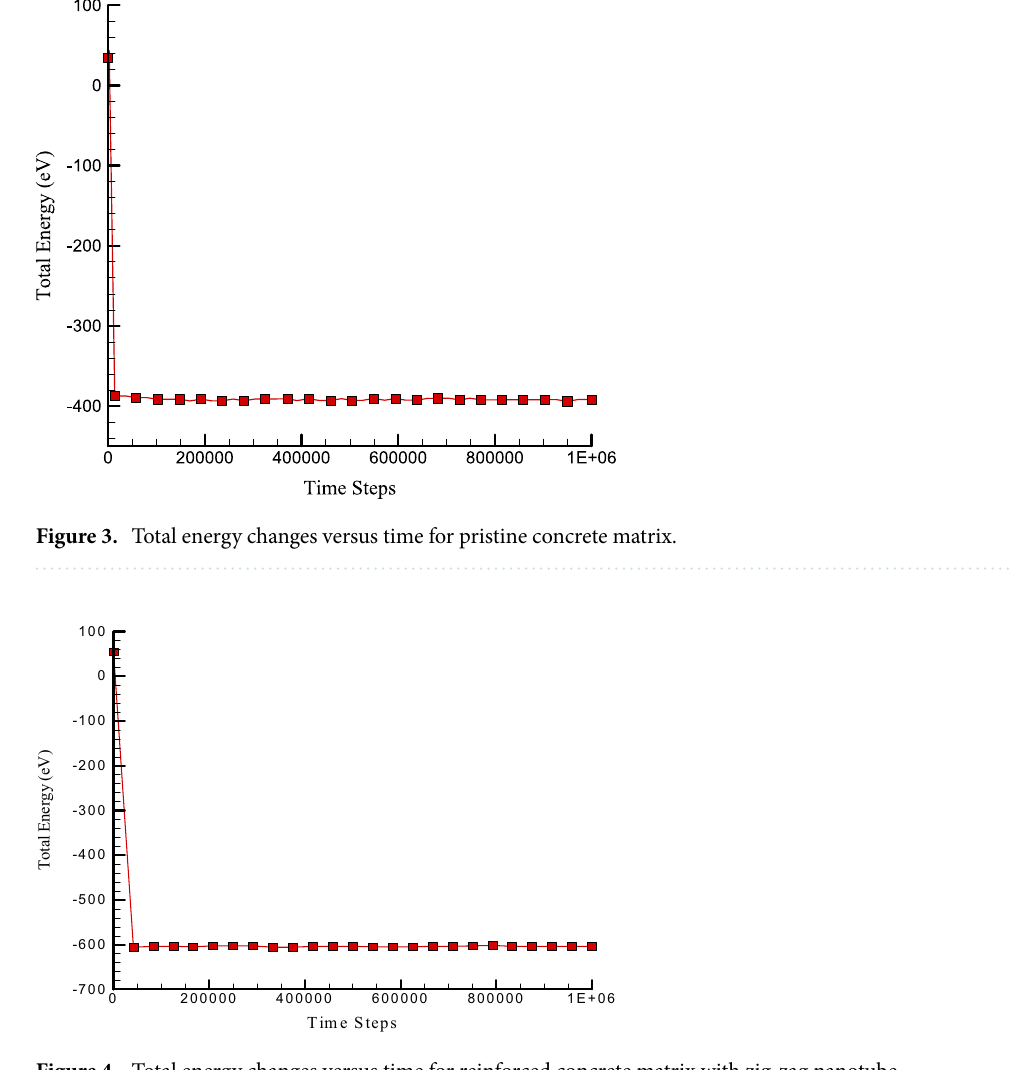
Figure 4. Total energy changes versus time for reinforced concrete matrix with zig-zag